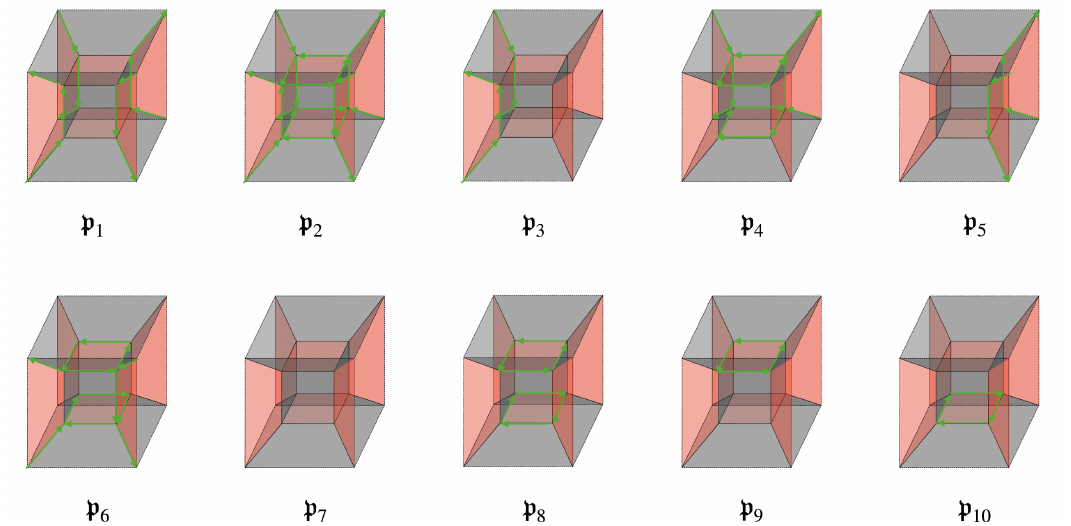
Figure 23 . Flows for the ten perfect matchings of the cube model shown in Figure 20 using p 7 as the reference, whose associated flow is therefore